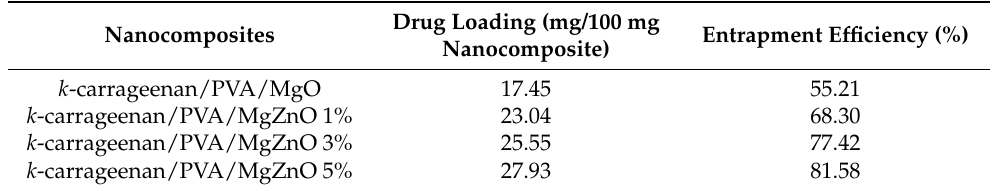
Table 4. The drug loading and entrapment efficiency (%) in k -carrageenan/PVA hydrogels containing MgZnO